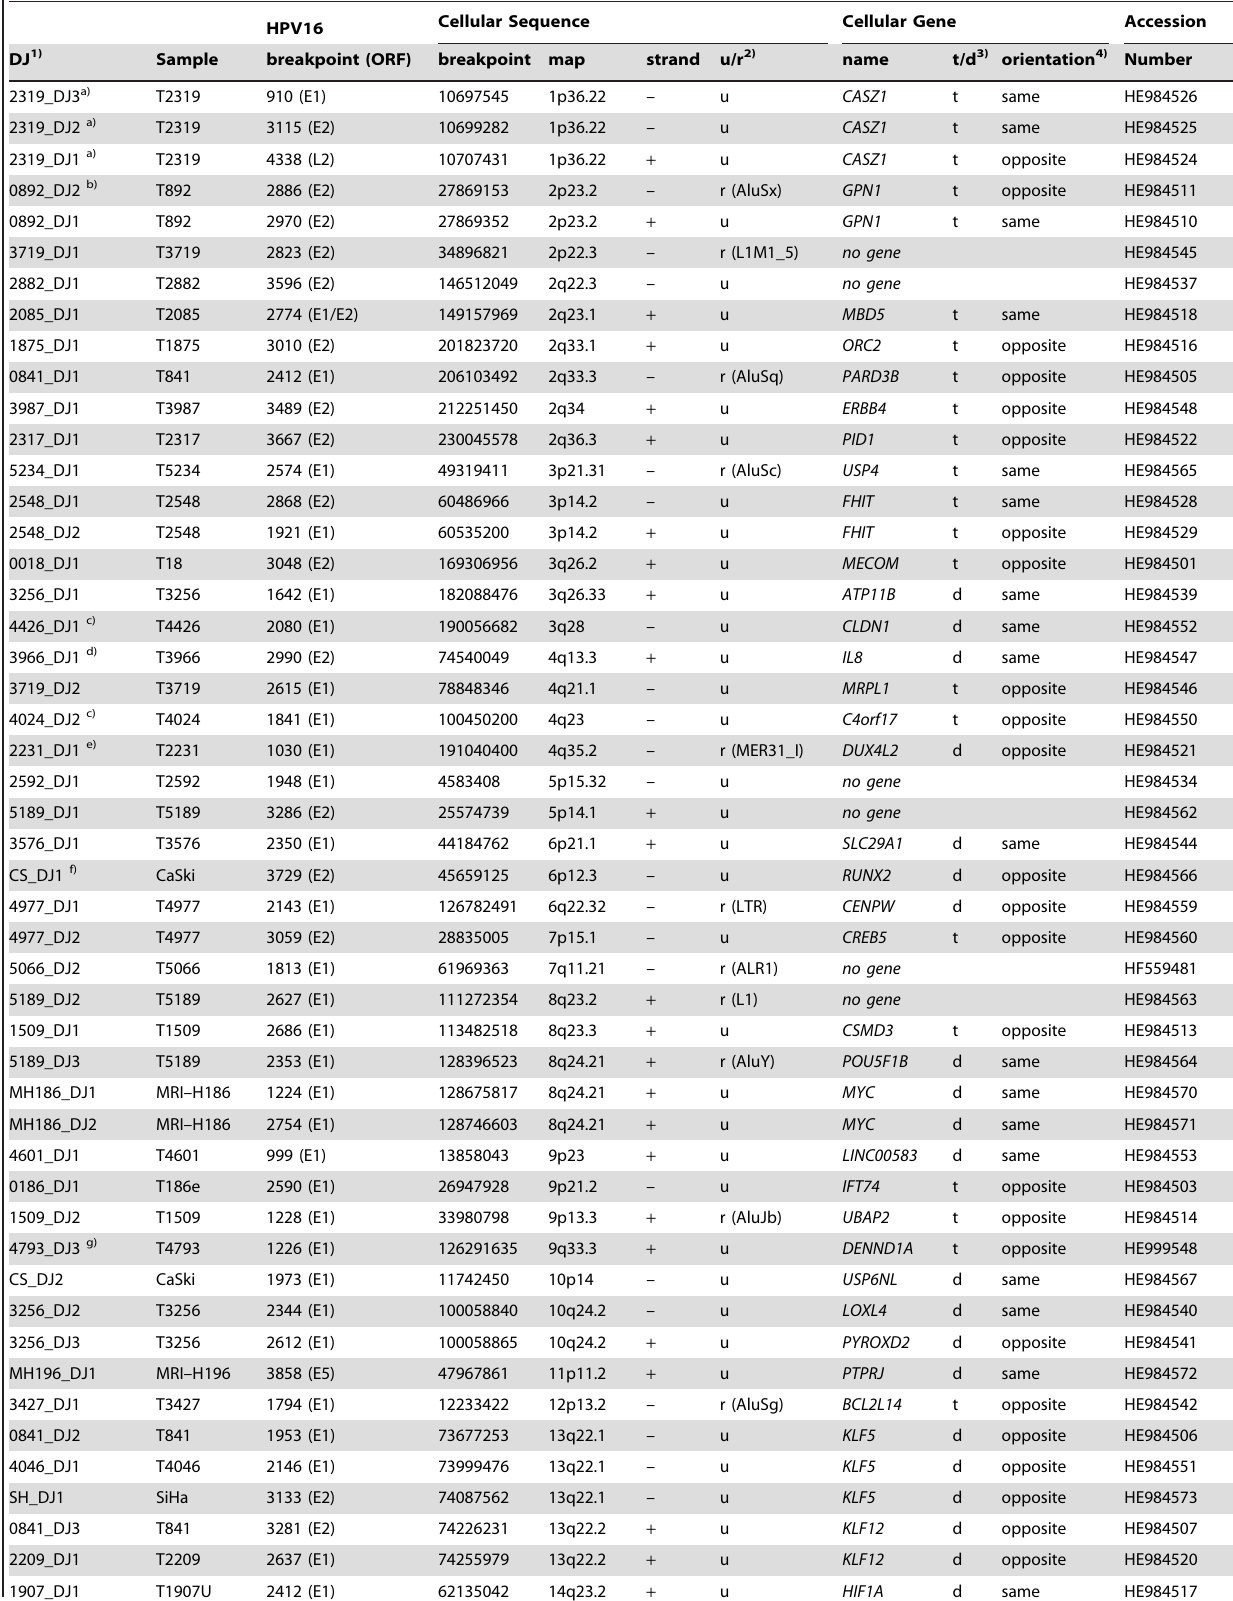
Table 1. HPV16-cellular DNA junctions validated by